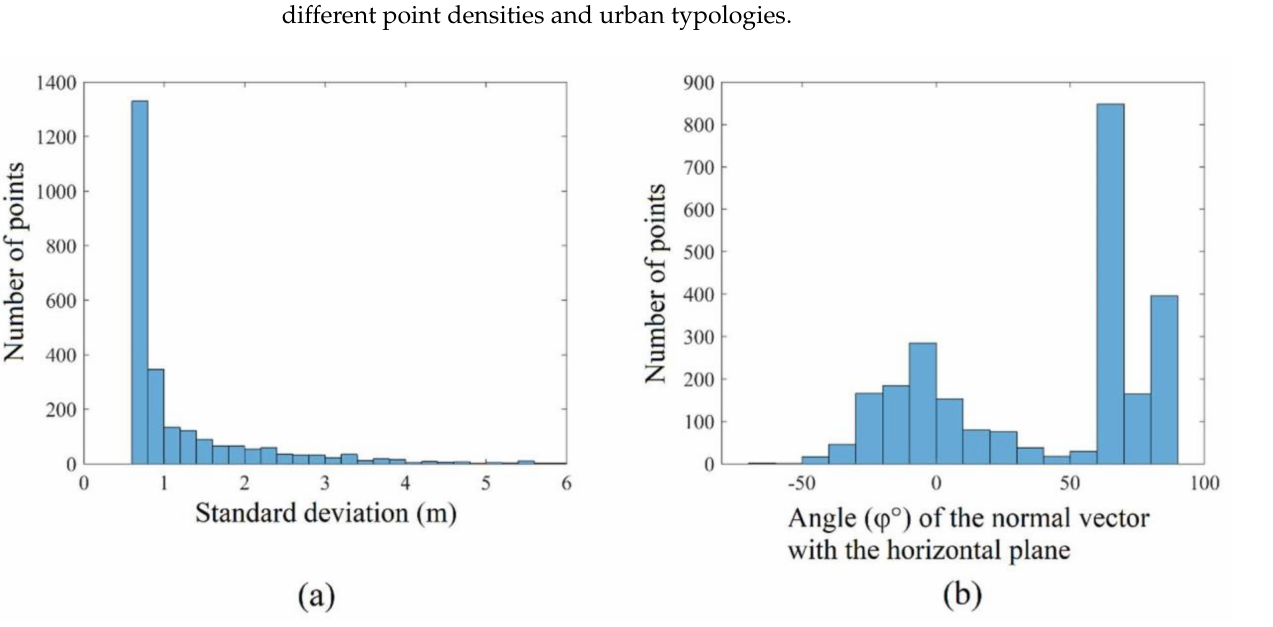
Figure 5. ( a , b ) Histograms of standard deviation ( σ ) and the angle ( ϕ ◦ ) of normal vector with horizontal plane of noisy point cloud.